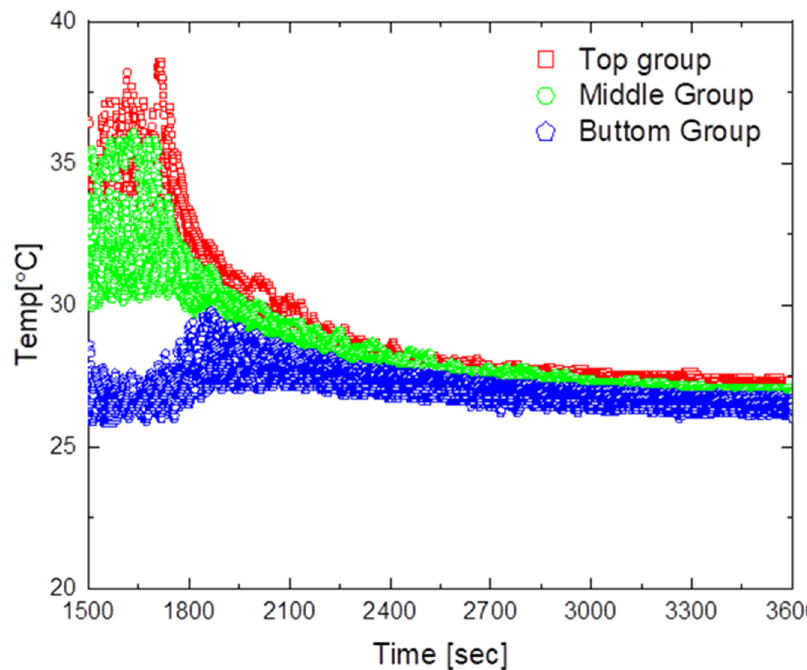
Figure 13. Temperature distribution for the air circulator operating at 6 m/s.